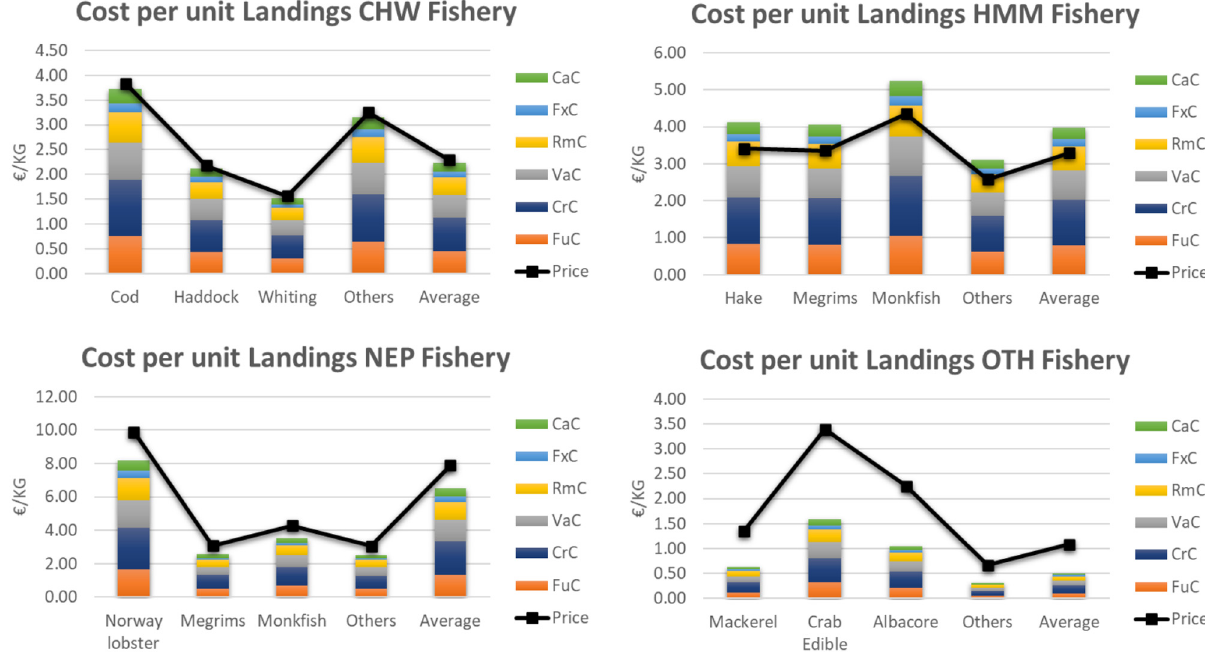
Fig. 6. Price and cost structure (fuel costs (FuC), other variable costs (VaC), crew costs (CrC), repair and maintenance costs (RmC), fi xed costs (FxC), capital costs (CaC)) of main fi sheries (cod, haddock, whiting (cid:2) CHW; hake, monk fi sh, megrim (cid:2) HMM; nephrops (cid:2) NEP; all others (cid:2) OTH) and main species exploited by the white fi sh fl eet in 2019 15 .